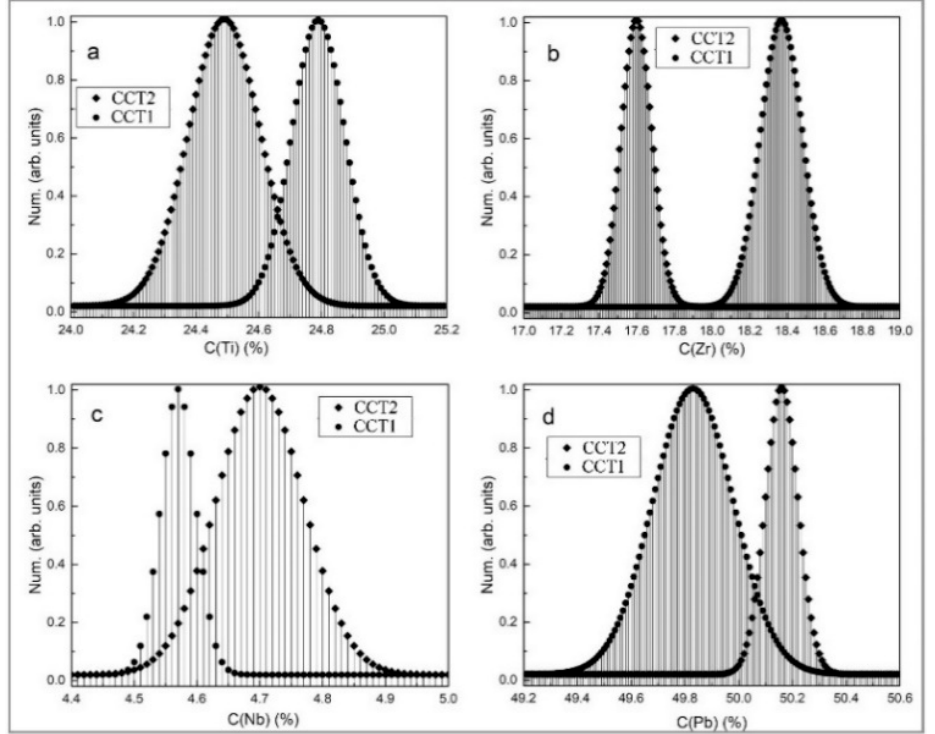
Figure 7. The concentration distributions for the samples obtained using micro-PCFA of two ceramic samples (CCT2 and CCT1).